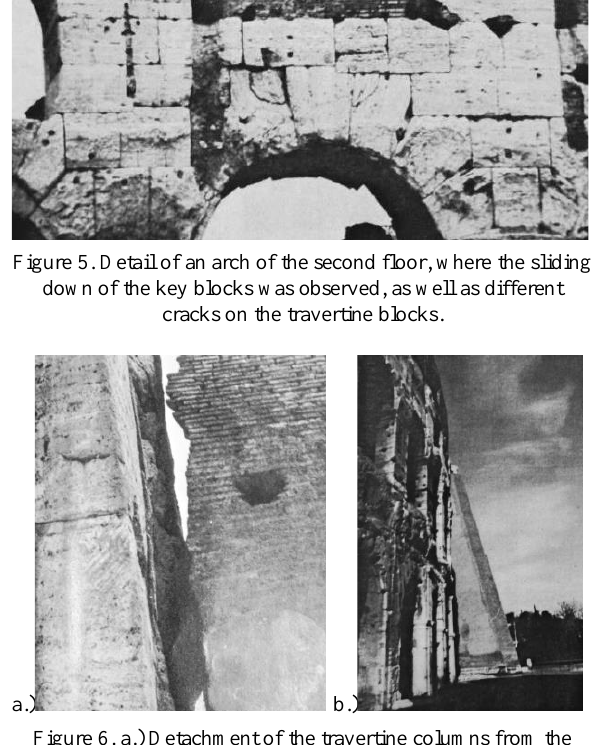
Figure 7. Construction of steel buttresses to prop up the columns of the first and second floors.